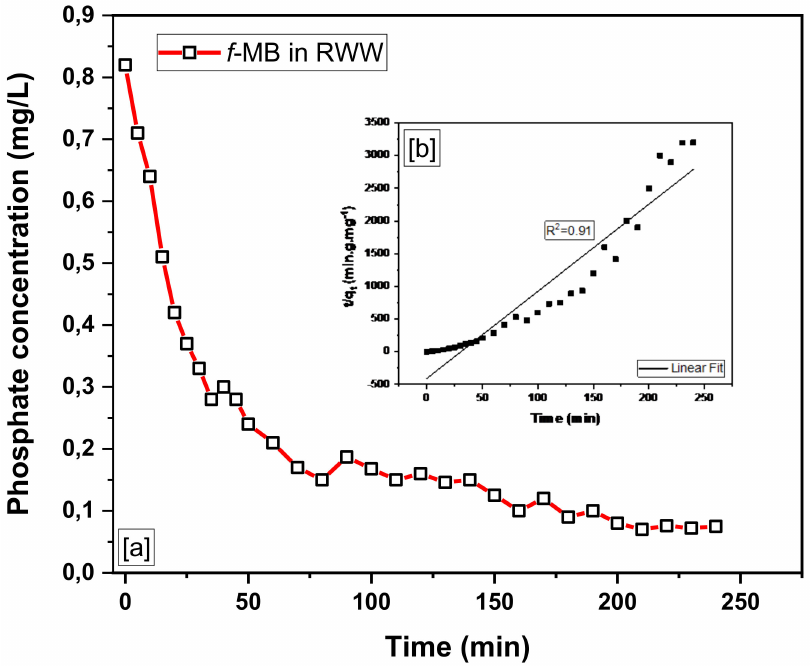
Figure 5. ( a ) Phosphate removal efficiency of f -MB in real wastewater. ( b ) Pseudo-second-order kinetics of phosphate-uptake by f -MB.